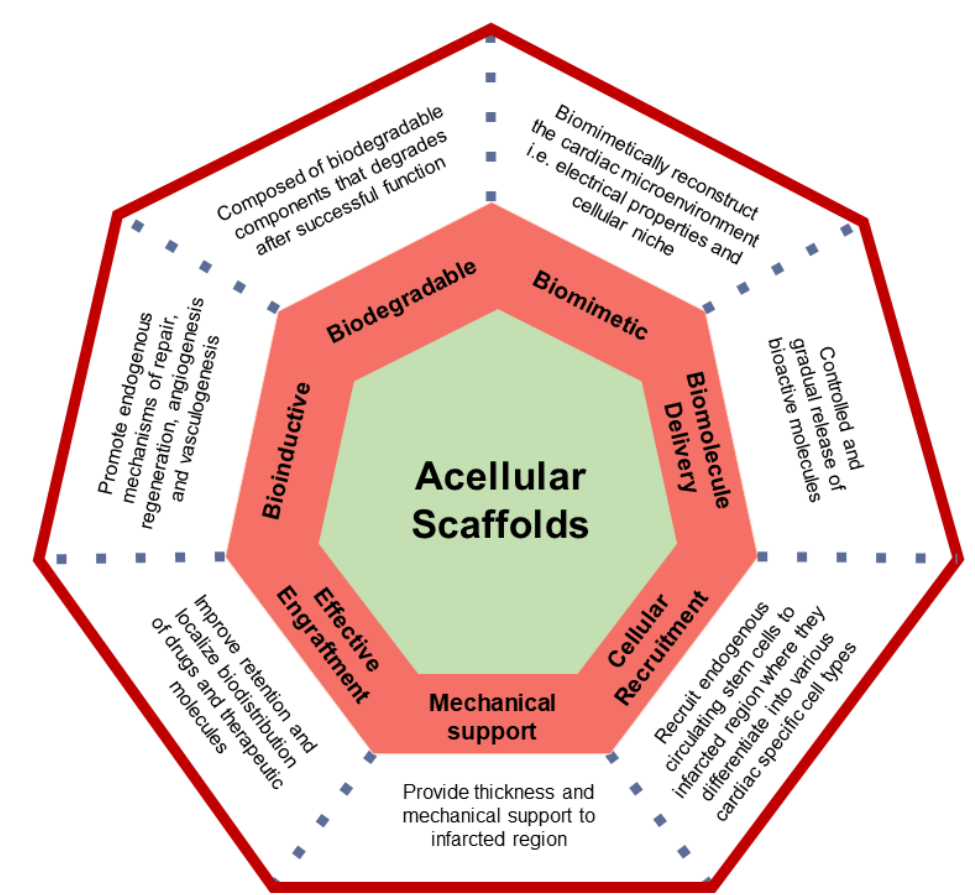
Figure 1. General characteristics of acellular scaffolds. Each characteristic is relevant to enable their use as therapeutic constructs to limit left ventricular remodelling. use as therapeutic constructs to limit left ventricular